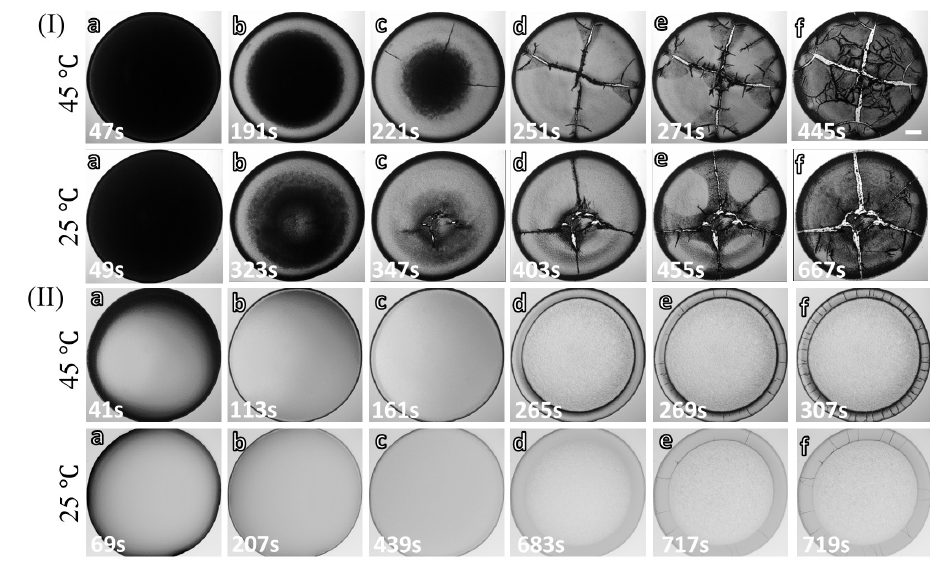
Figure 2. Time evolution of the blood droplets during the drying process: ( a – f ) display the drying stages at the substrate temperature (T) of 45 and 25 ◦ C at the initial concentration ( φ b ) of 100% ( v / v ) in ( I ) and 12.5% ( v / v ) in ( II ). The scale bar of length 0.2 mm is represented with the white rectangle in the top-right